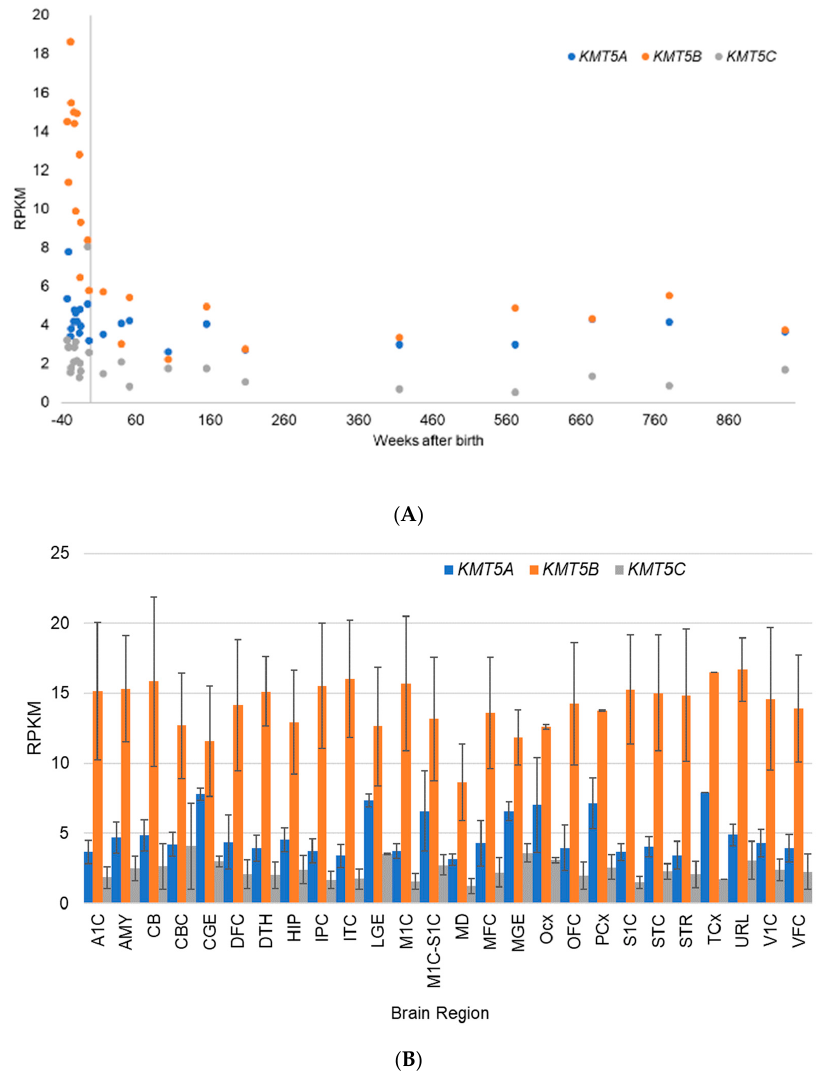
Figure 4. Developmental transcriptome data for the human KMT genes from the Allen BrainSpan Atlas [82]. ( A ) Scatterplot shows average expression across all brains regions by age from conception ( − 40 weeks) to 18 years old (936 weeks); and ( B ) bar graph shows average expression by brain region for data points from all individuals before birth (i.e., week 0). As defined by the Allen BrainSpan Atlas: A1C: primary auditory cortex (core); AMY: amygdaloid complex; CB: cerebellum; CBC: cerebellar cortex; CGE: caudal ganglionic eminence; DFC: dorsolateral prefrontal cortex; DTH: dorsal thalamus; HIP: hippocampus (hippocampal formation); IPC: posteroventral (inferior) parietal cortex; ITC: inferolateral temporal cortex (area TEv, area 20); LGE: lateral ganglionic eminence; M1C: primary motor cortex (area M1, area 4); M1C-S1C: primary motor-sensory cortex (samples); MD: mediodorsal nucleus of thalamus; MFC: anterior (rostral) cingulate (medial prefrontal) cortex; MGE: medial ganglionic eminence; Ocx: occipital neocortex; OFC: orbital frontal cortex; PCx: parietal neocortex; S1C: primary somatosensory cortex (area S1, areas 3,1,2); STC: posterior (caudal) superior temporal cortex (area 22c); STR: striatum; TCx: temporal neocortex (n = 1); URL: upper (rostral) rhombic lip; V1C: primary visual cortex (striate cortex, area V1/17); and VFC: ventrolateral prefrontal cortex. Error bars represent the standard deviation of the